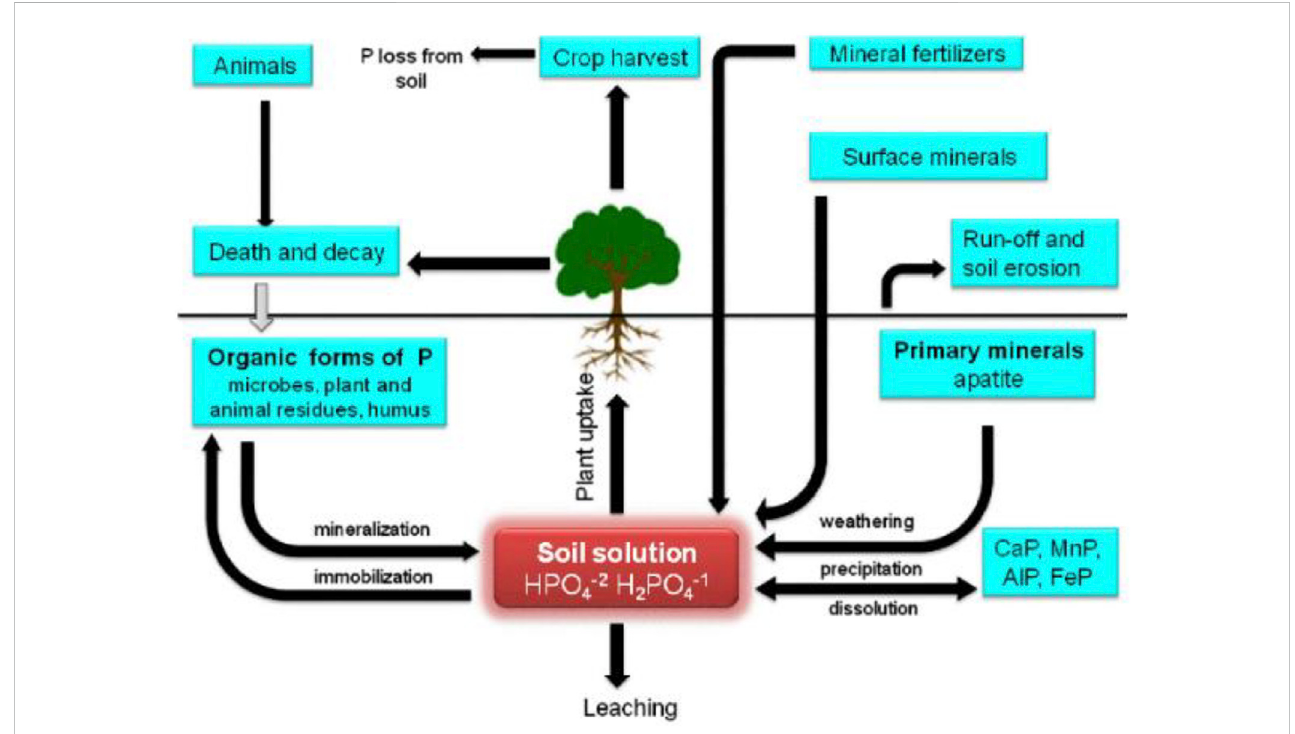
FIGURE 3 Movement of phosphorus in soil systems adopted from (Ahemad and Kibret 2014).